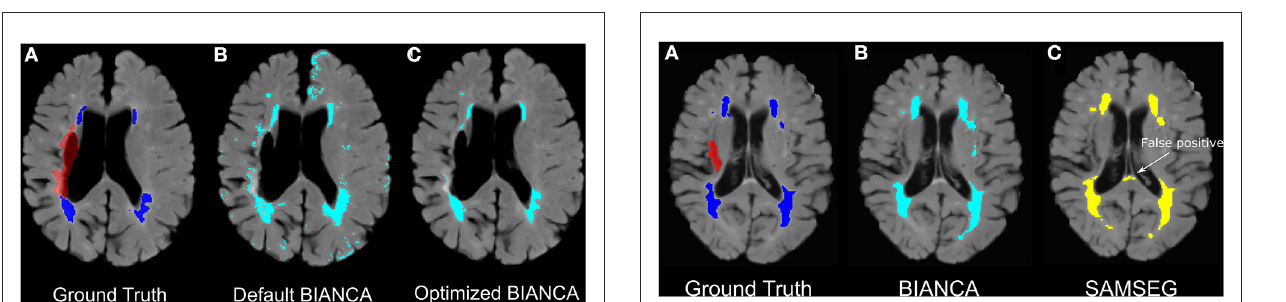
FIGURE5 Example improvements in BIANCA WMH segmentation in an individual with chronic stroke. Panels present (A) ground truth WMH masks from SABRE segmentation (in dark blue) and the stroke lesion mask (in red-excluded from BIANCA segmentations), (B) + (C) : automated WMH segmentation between default BIANCA options (B) and BIANCA segmentation with the set of optimized BIANCA parameters described in the current report (C) .